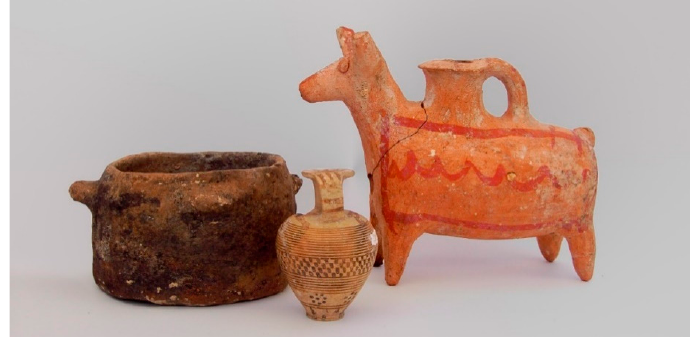
Figure 18. Container in the shape of cow (MGW inv. no. 4386) together with two other vessels; ceramic vessel; ca. 6th century BCE .